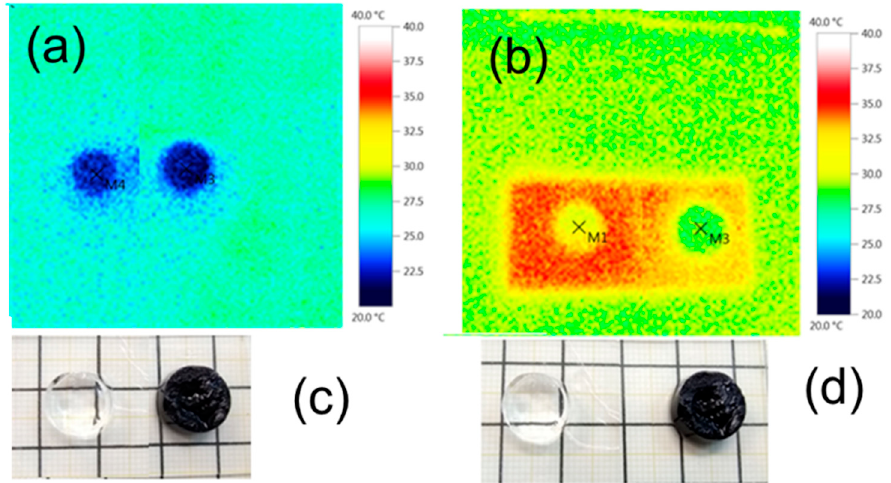
Figure 4. E ff ect of microwaves on the hydrogel (transparent) and the deprotonated (undoped) nanocomposite (blue) made by IPH. The upper panels ( a , b ) show the thermographic images before ( a ) and after ( b ) irradiation with microwaves by 10 s. The scales at the left of each panel link color with temperatures. The lower panels ( c , d ) show the optical photographs of the hydrogel (transparent, left) and nanocomposite (blue, right) before ( c ) and after ( d ) microwave (2.4 GHz, 70 W) irradiation for 10 s.